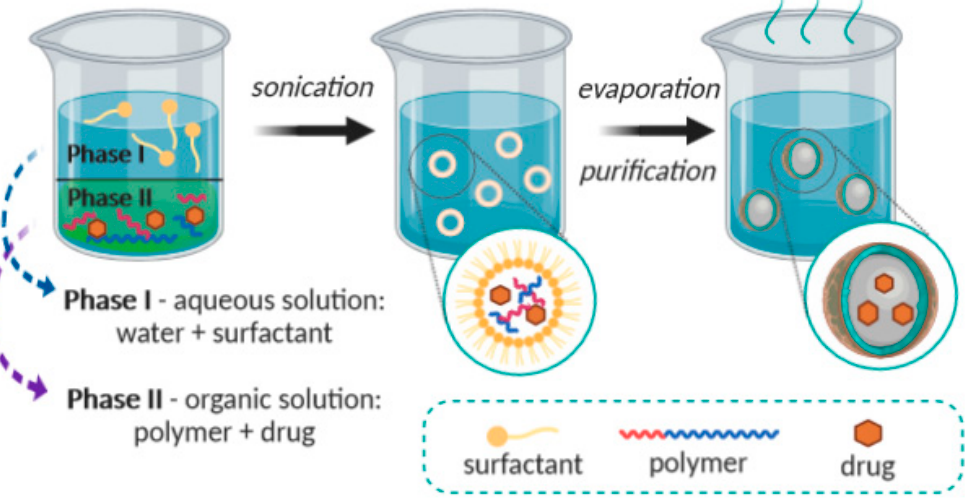
Figure 2. Schematic representation of the solvent evaporation method.